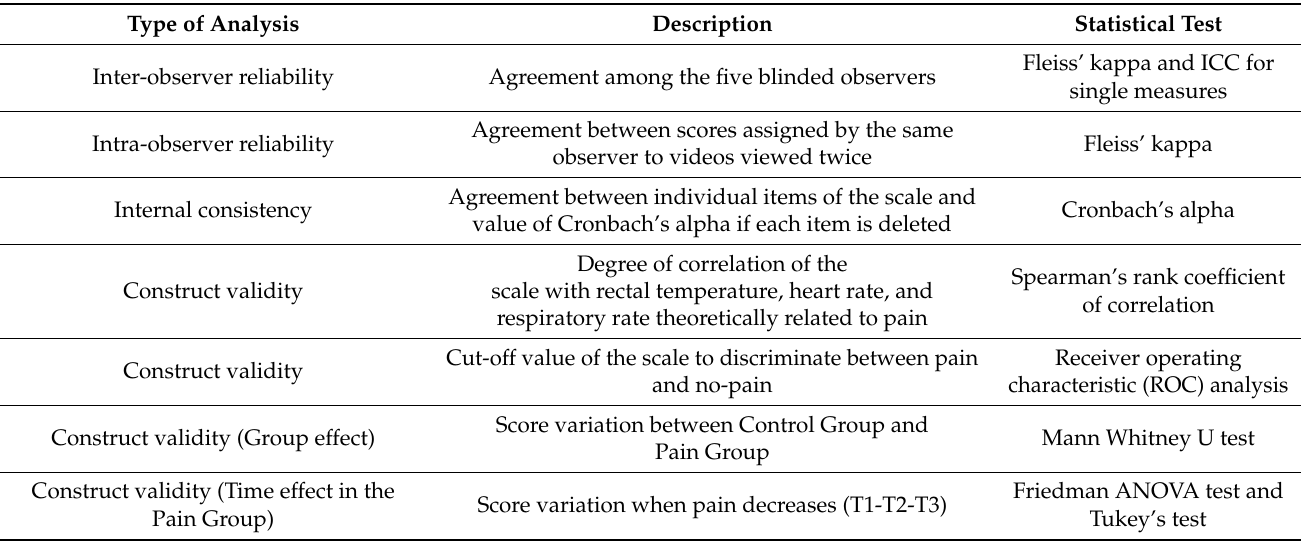
Table 2. Statistical methods employed in the validation process of the FCPS.